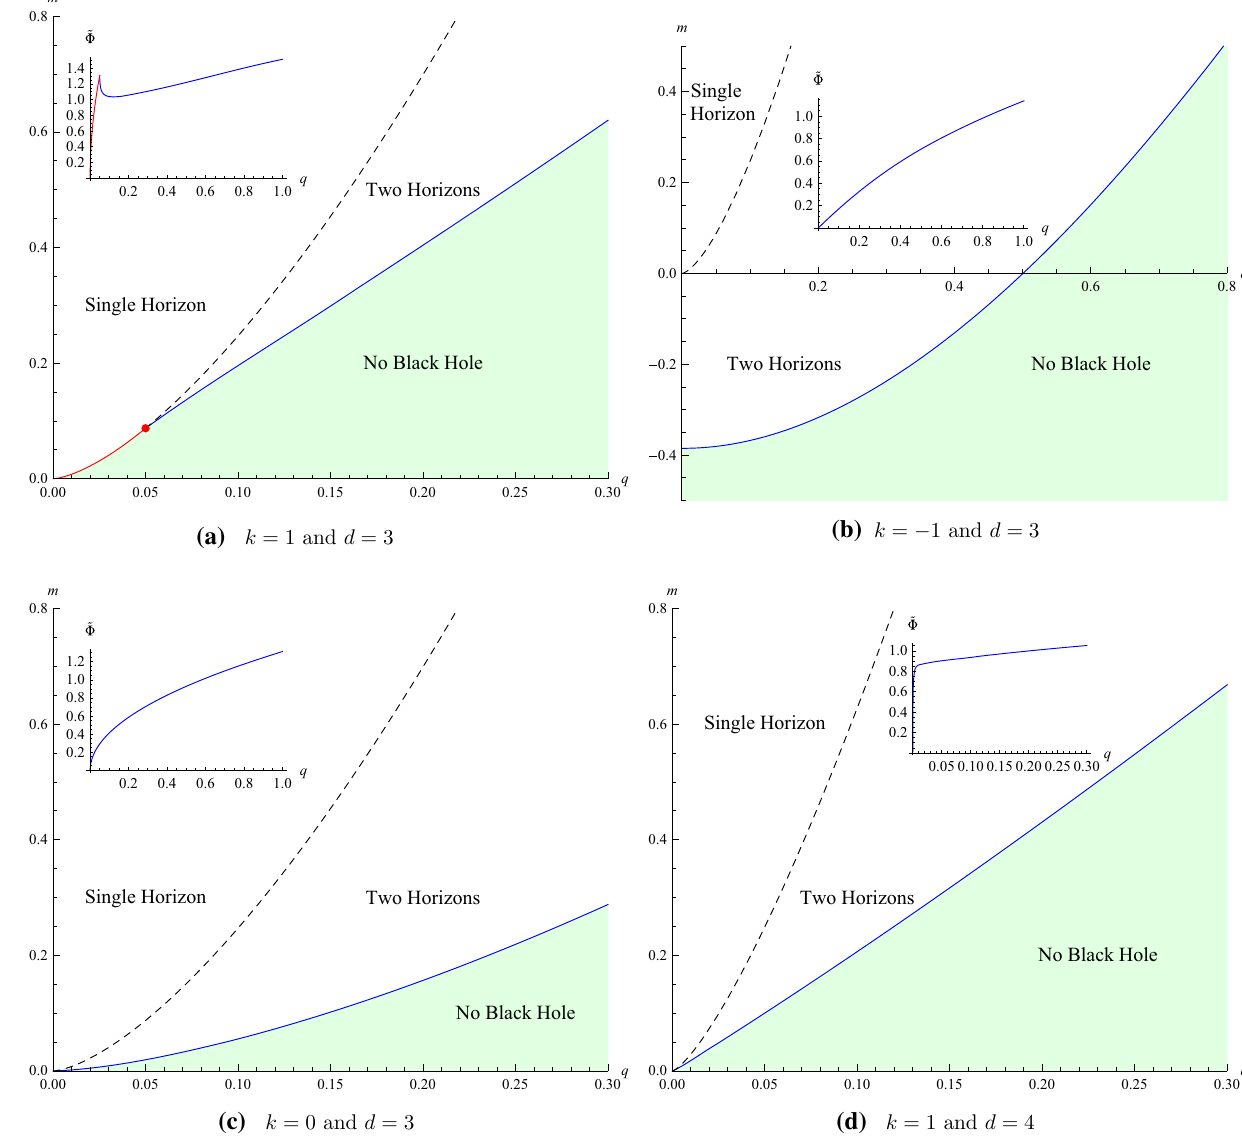
r h = 0. When β → ∞ , the Born–Infeld AdS black holes become the RN AdS black holes. When k = 1 and d = 3, it was found [11] that the boundary of RN AdS black holes in the phase diagram was the extremal line, and the potential (cid:3) approached 16 π as ( q , m ) → ( 0 , 0 ) along the extremal line. Thus, for a RN AdS black hole, the ground state of the geometry with the same electrostatic potential as ≤ 1, but for this black hole is pure AdS spacetime for (cid:3) 16 π (cid:3) > 1 it is some extremal black hole. Now we compute 16 π the asymptotic behavior of (cid:3) as ( q , m ) → ( 0 , 0 ) along the